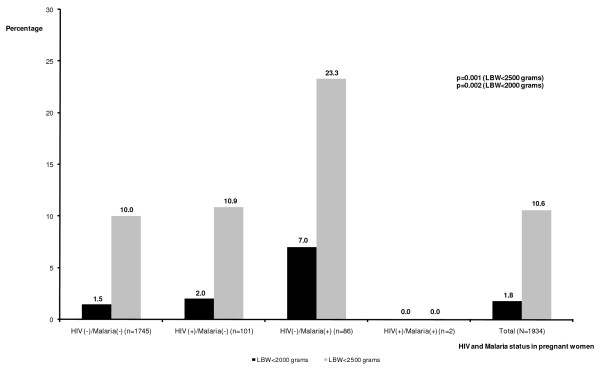
Low birth weight (LBW) according to HIV and malaria status in pregnant women in delivery wards in Côte d'Ivoire, 2008-2009.